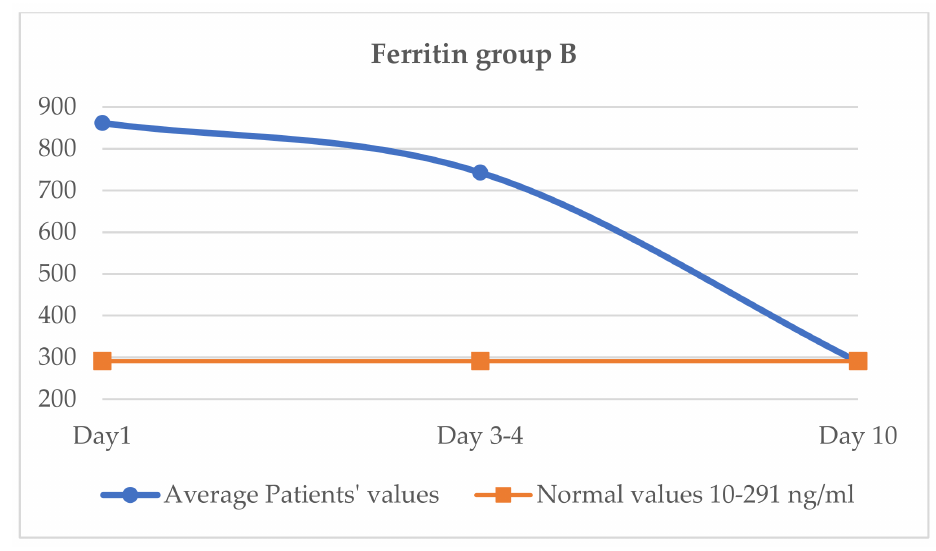
Figure 6. Variation of ferritin group B.